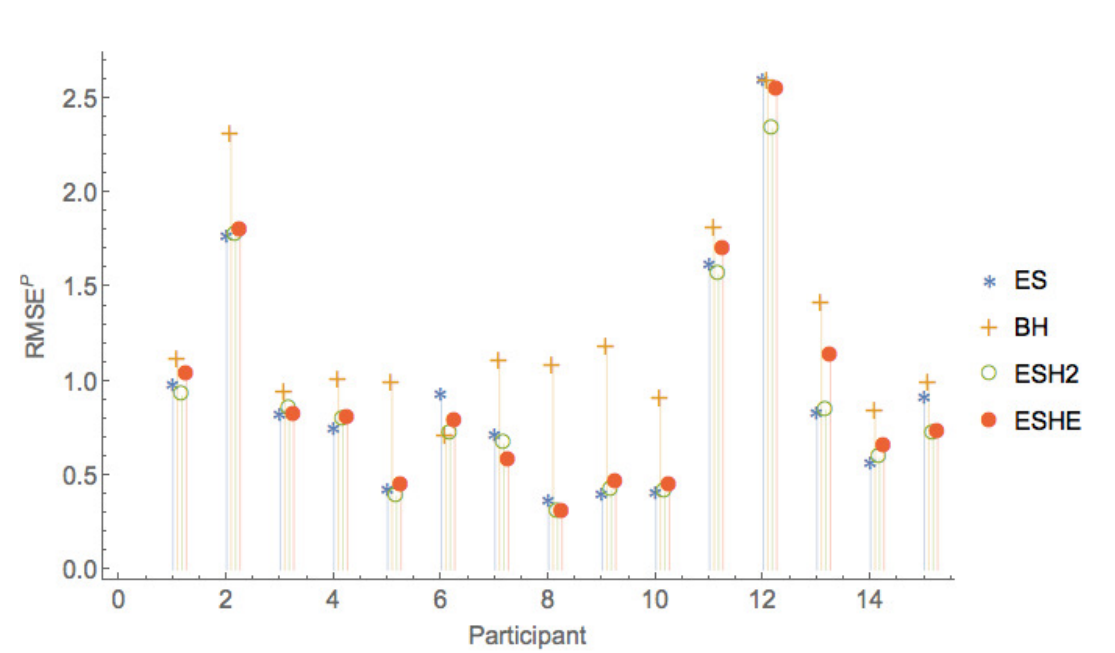
Figure 10. Comparison of leave-one-period-out LOOCV RMSE of selected models for Session 3.